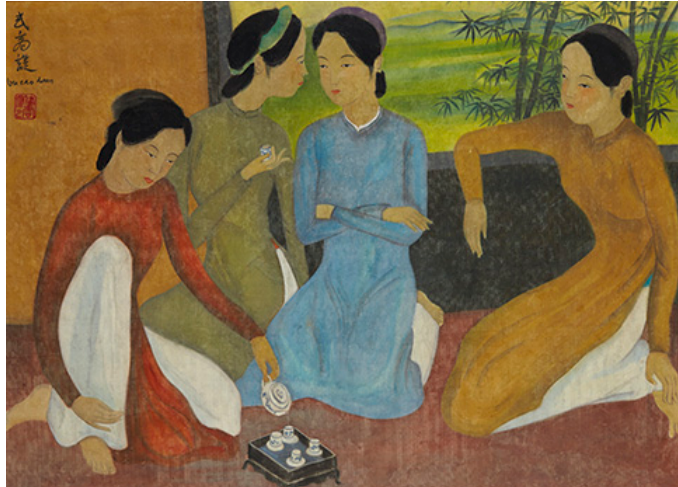
Figure 9. Thieu nu uong tra —Vu Cao Dam (fake); auctioned at Auction.fr, May 2016. The image was sourced from The Thao & Van Hoa Newspaper (Bay 2016b). Arts 2018 , 7 , x FOR PEER REVIEW 12 of 36